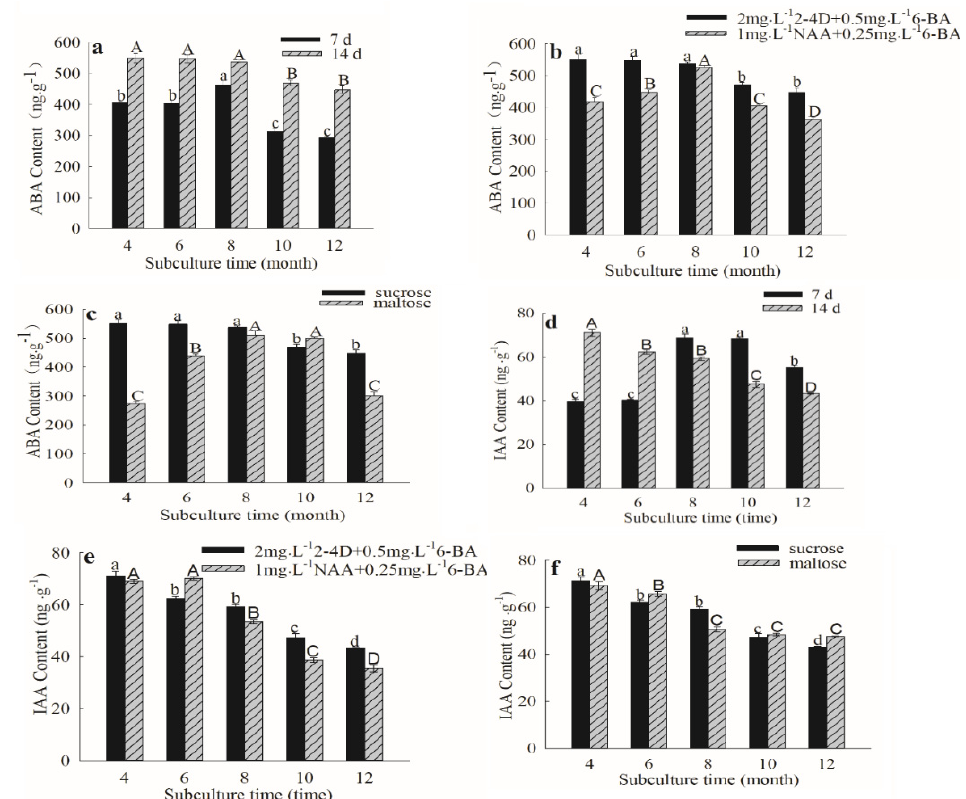
Figure 2. Effects of subculture cycle, hormone ratio, and carbon source on ABA and IAA contents of Pinus koraiensis embryogenic callus during long-term subculture. ( a ) ABA content of callus in different subculture cycles, ( b ) ABA content of callus with different hormone ratios, ( c ) ABA content in callus of different carbon sources, ( d ) IAA content of callus in different subculture cycles, ( e ) IAA content of callus with different hormone ratios, ( f ) IAA content in callus of different carbon sources; Note: Different letters (upper or lower case) in the table indicate significant differences between columns (Duncan’s multiple range test; p = 0.05).